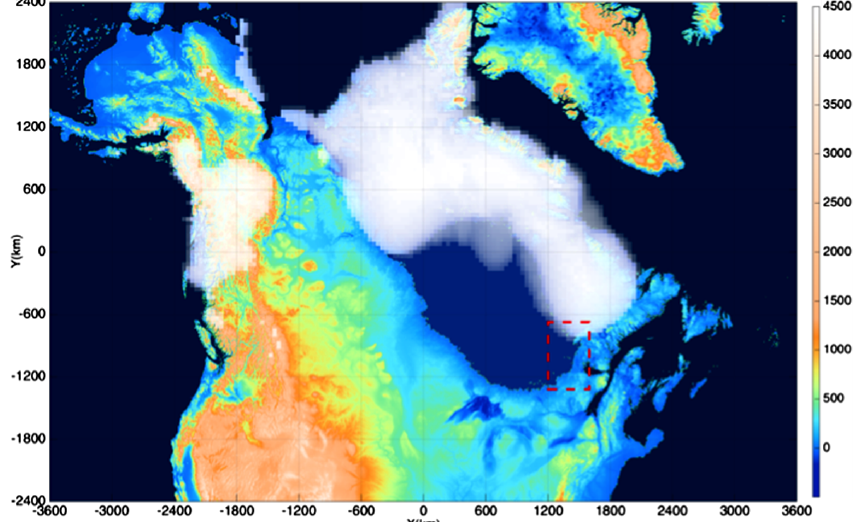
Figure 5. North America, the Laurentide ice sheet and Lake Agassiz, 30ky before present. The red outlined region is shown in close-up in Fig. 6.